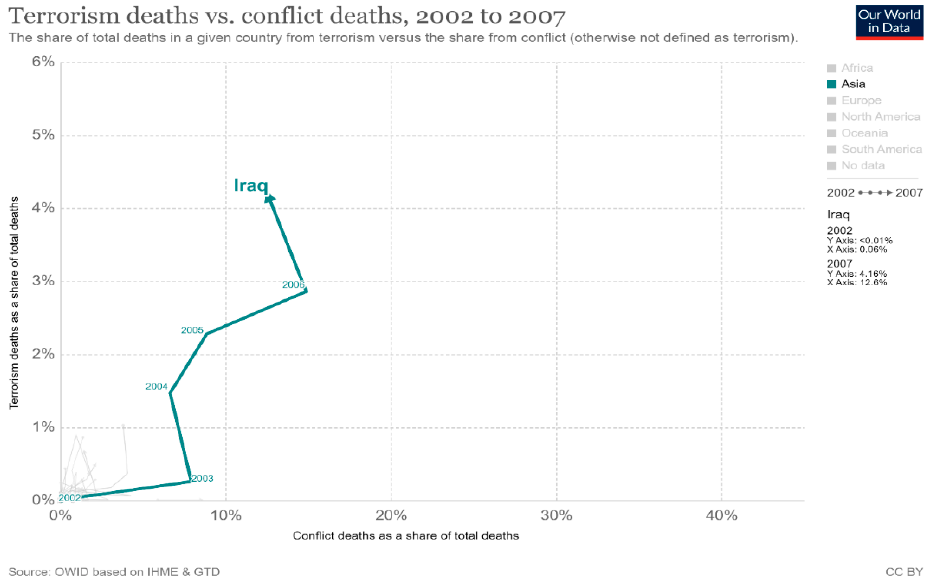
Figure 2. Fatalities of terrorism compared to fatalities of conflict in Iraq between 2002 and 2007.